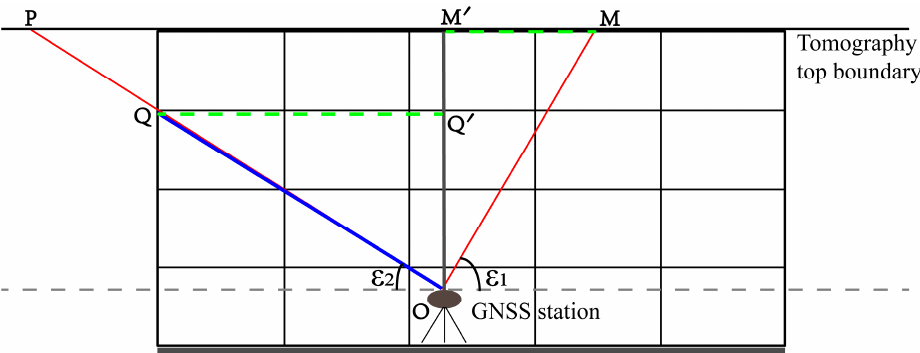
Figure 2. Two-dimensional schematic diagram of the height factor model (HFM) to illustrate the estimation method of sectional slant wet delay (SWD) for top and side signals.